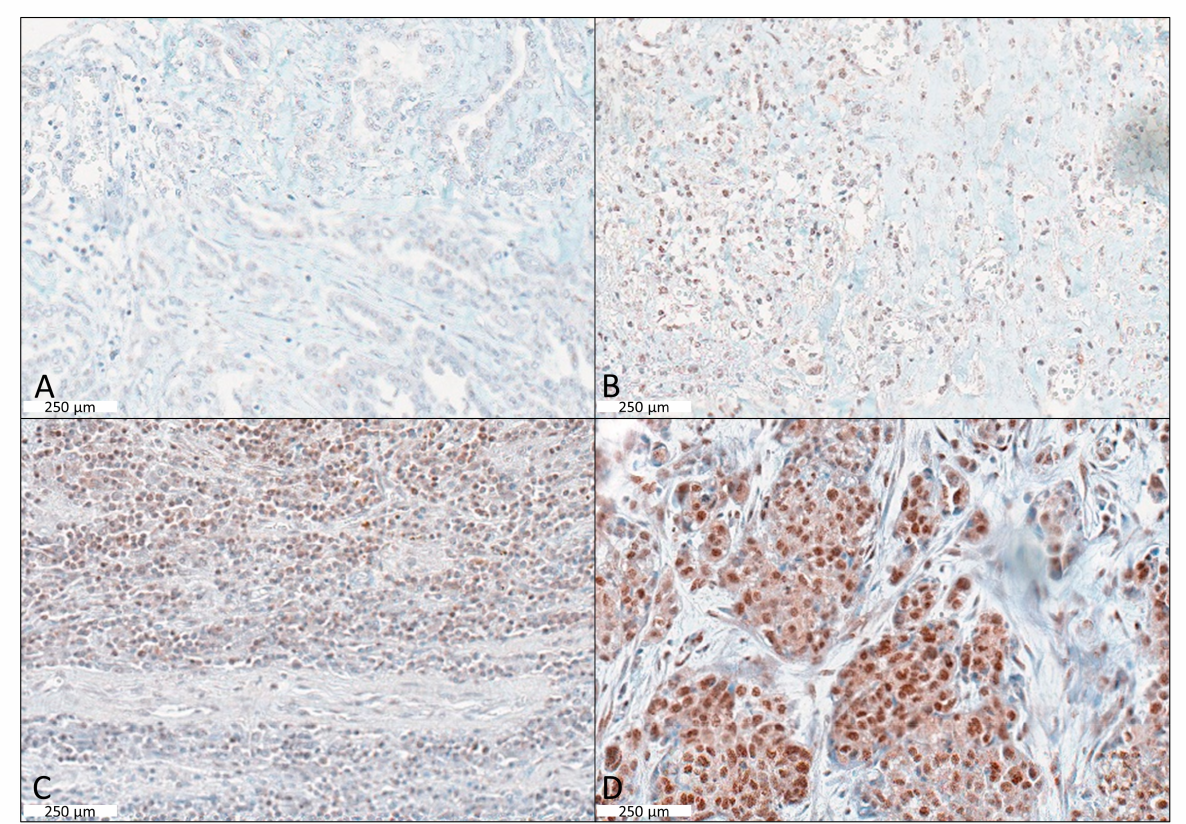
Figure 1. Cases of immunohistochemically CXCR4 staining representing the scoring 0–3. ( A ) IHC negative epithelioid MPM (Score 0). ( B ) Immunohistochemically weak nuclear positive MPM (Score 1). ( C ) Immunohistochemically moderate to strong nuclear positive MPM (Score 2). ( D ) Immunohis- tochemically strong nuclear expressing MPM (Score 3). Scale bar indicates 250 µ